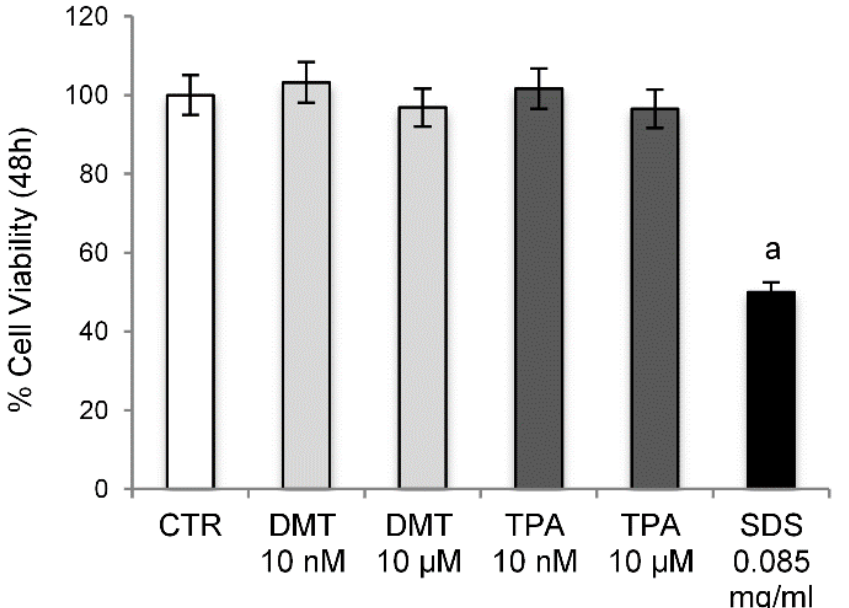
Figure 1. Cell Viability. Cytotoxicity was evaluated by sulforhodamine B assay on NIH/3T3 cells treated with different concentrations of the tested compounds for 48 h. Control cells were treated with the vehicle (DMSO) alone. SDS was used as a positive control. a p < 0.05 vs. CTR. As reported in Table 1, the tested compounds followed Lipinski’s rules for drug- likeness with no violation. Regarding the in silico ADME analysis, the results may be interpreted based on the marginal value compared with the resultant value as follows: High Caco-2 permeability is predicted by a value > 0.90, and intestinal absorption less than 30% is considered poorly absorbed; human VDss is low if below 0.71 L/kg and high if above 2.81 L/kg. In particular, both tested compounds appear to possess good oral bioavailability. The percentage of intestinal absorption of all the compounds has been calculated with values ranging from 75% (TPA) to 90% (DMT) and confirmed with Caco-2